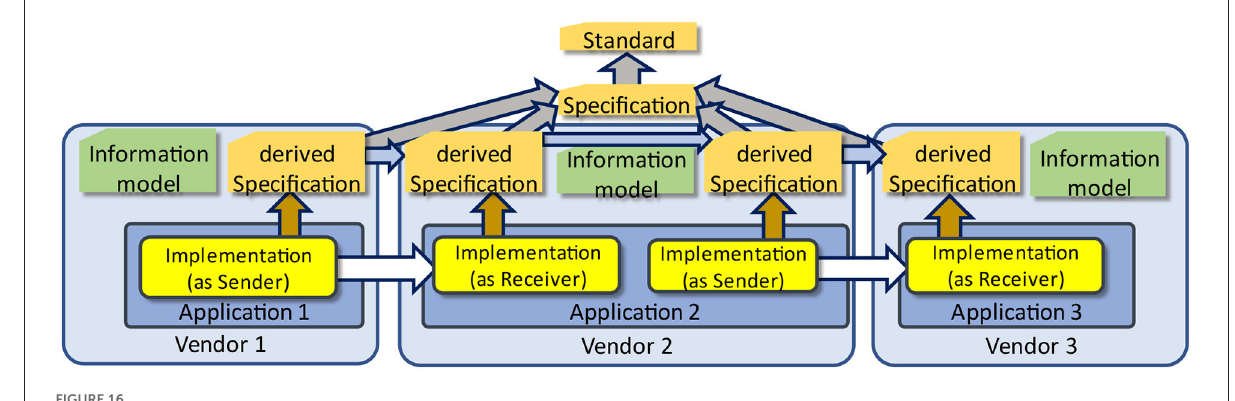
FIGURE16 Information models within